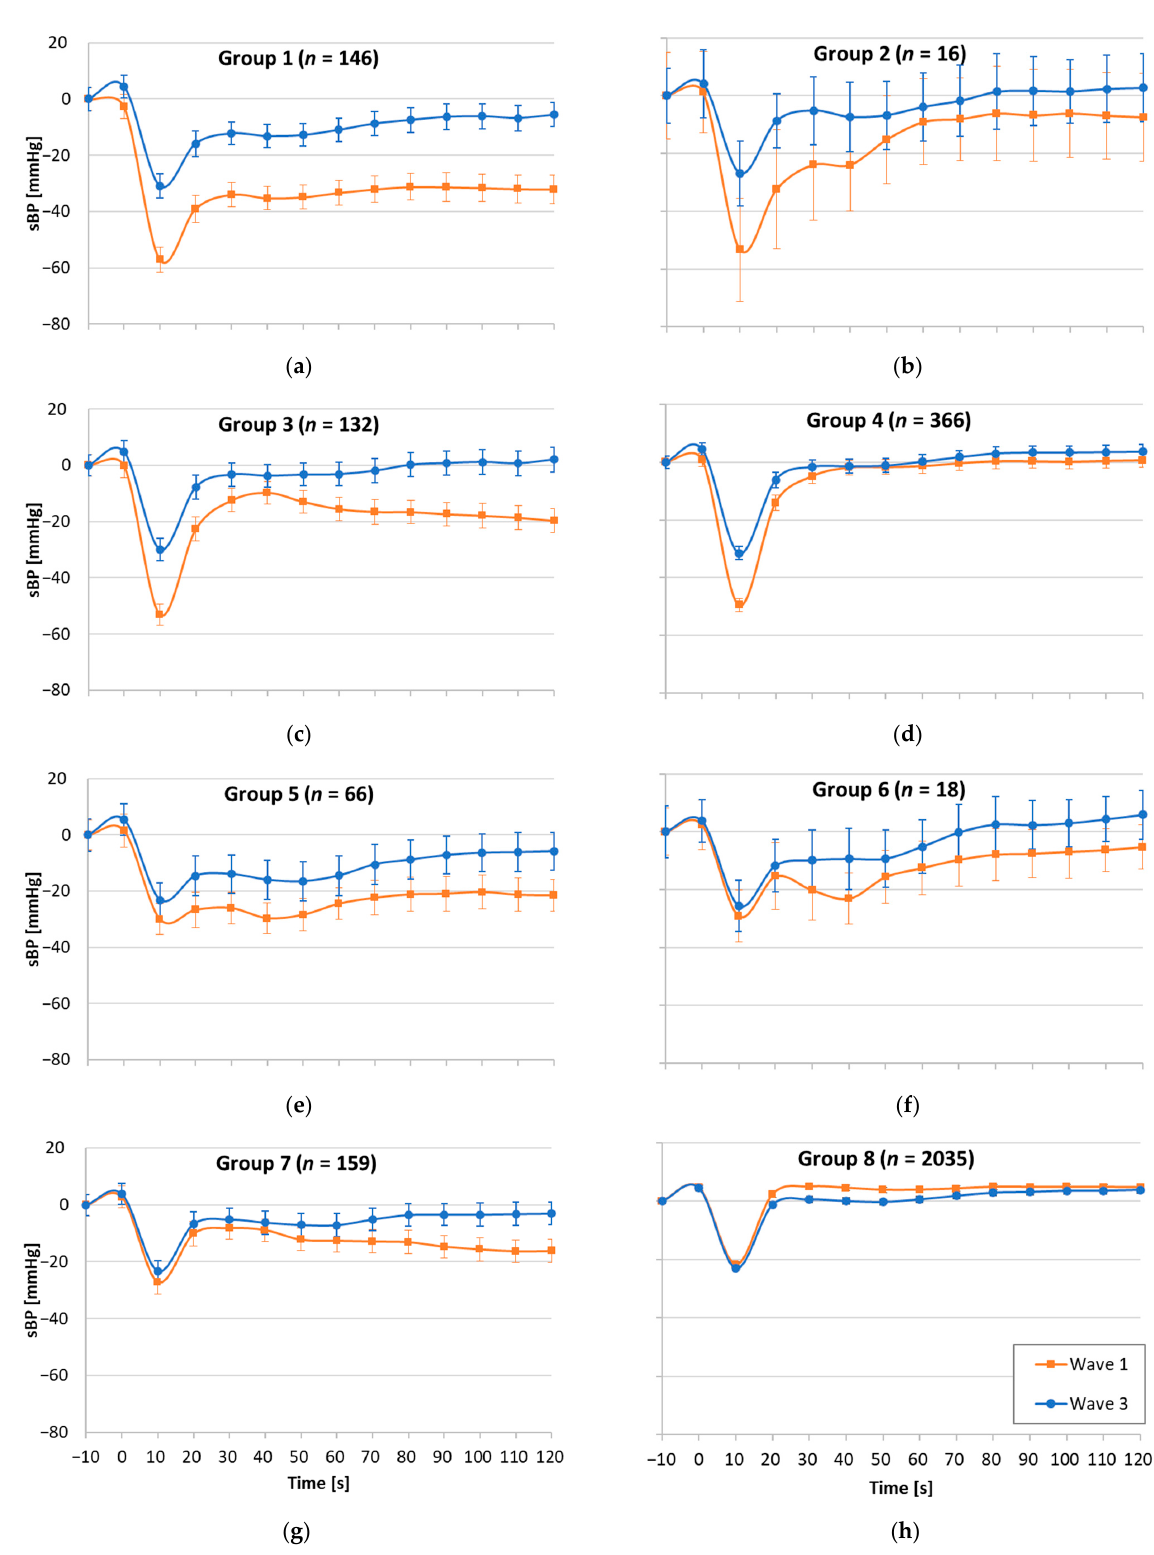
Figure 2. Graphical visualisation of the orthostatic systolic blood pressure active stand profiles of the eight groups at Wave 1 and Wave 3. SBP: systolic blood pressure. ( a ): Group 1. ( b ): Group 2. ( c ): Group 3. ( d ): Group 4. ( e ): Group 5. ( f ): Group 6. ( g ): Group 7. ( h ): Group 8. Table 2. Results of the fully adjusted logistic regression models (Models C). Statistically significant results are highlighted in bold.